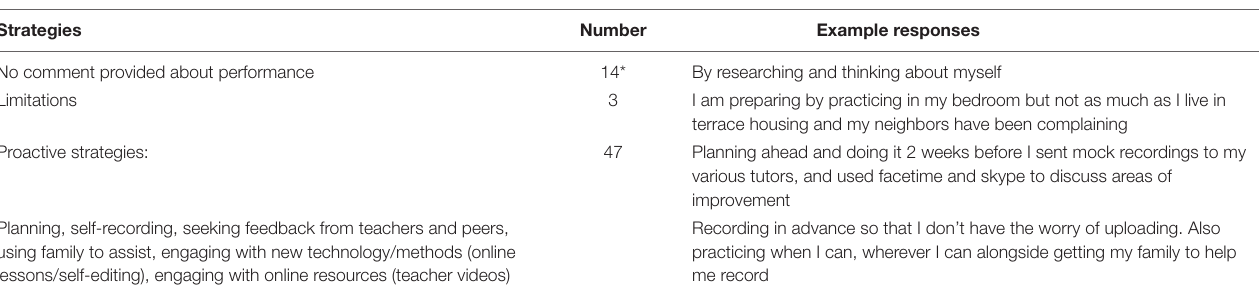
TABLE 6 | Assessment preparation strategies for students choosing to submit by the originally published deadline.